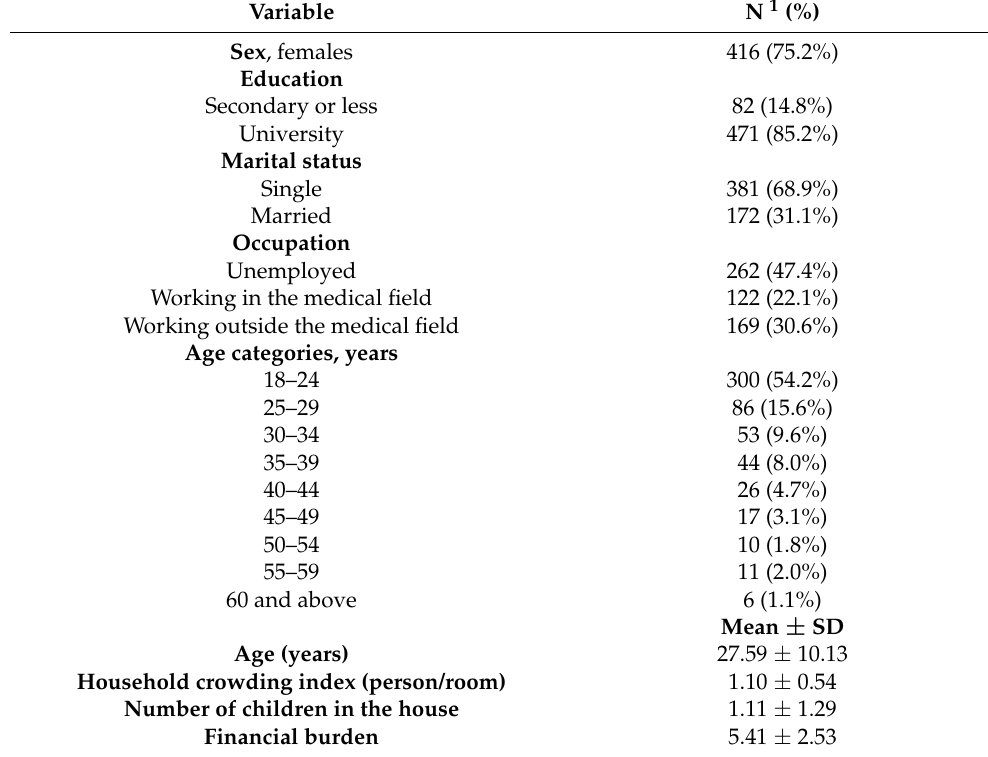
Table 1. Sociodemographic characteristics of the participants ( N =